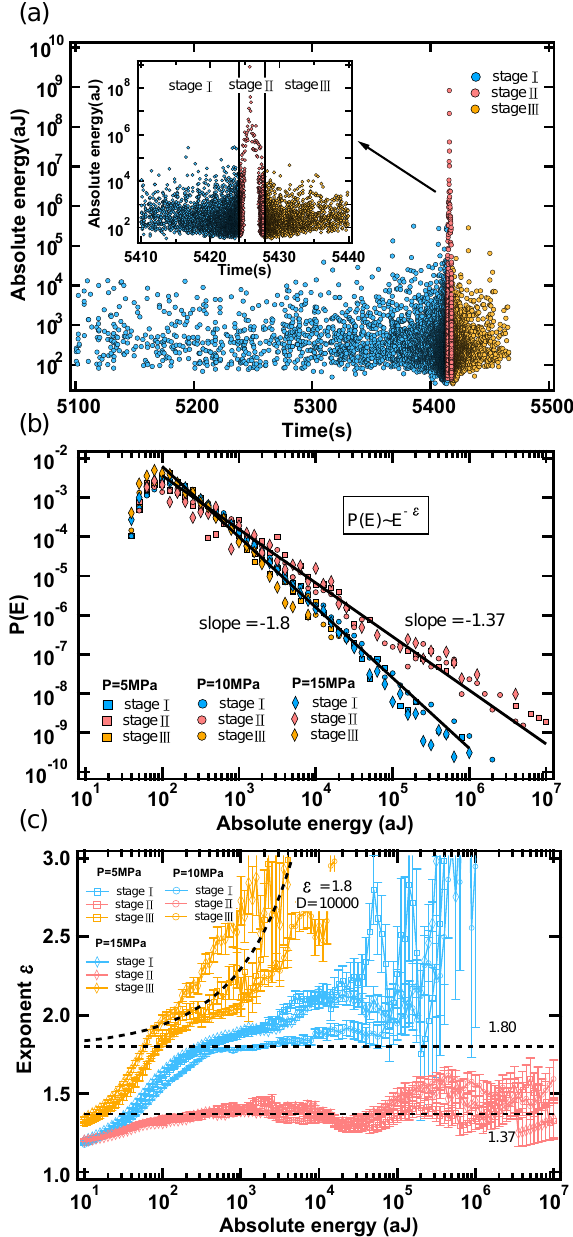
Figure 4. ( a ) The compression process is divided into three stages: (I) pre-failure, (II) correlated failure, and (III) a post-failure. ( b ) Distribution of avalanche energies for different stages. These distributions are power-law distributed. ( c ) The ML fitting exponent ε as a function of the lower threshold energy for different stages.